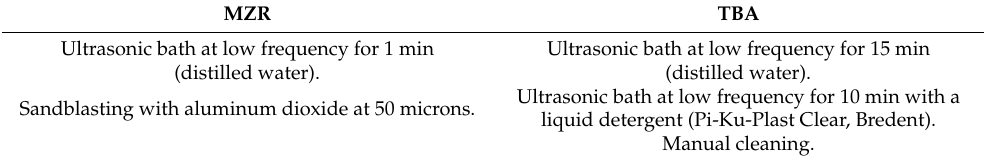
Table 5. Cleaning procedure after debonding: treatment of the MZRs and the TBAs. MZR TBA Ultrasonic bath at low frequency for 1 min (distilled